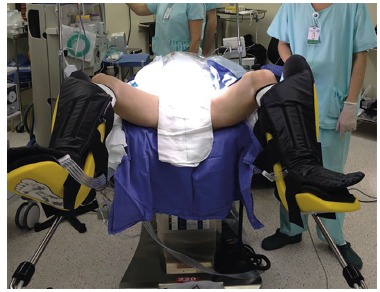
Patient positioning